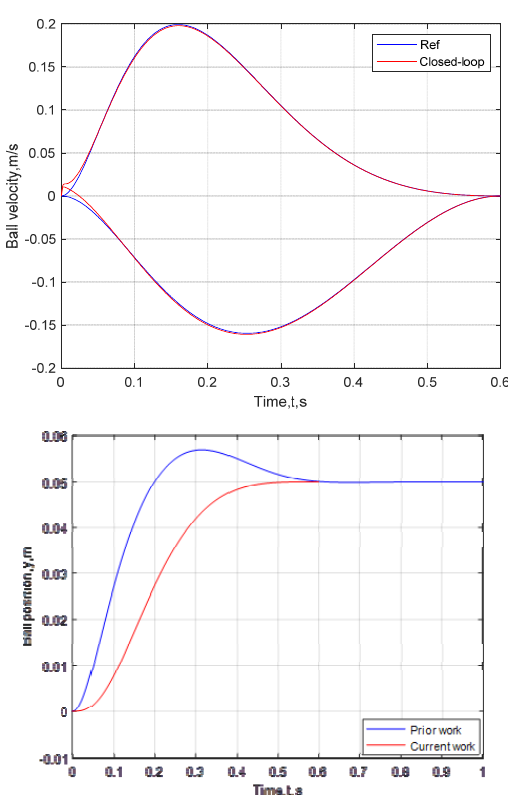
Figure 7. Actual ball position profiles for the current and prior woks); (a) ball position vs. time for y 0 = 0 m; (b) ball position vs. time for y 0 = 0.07